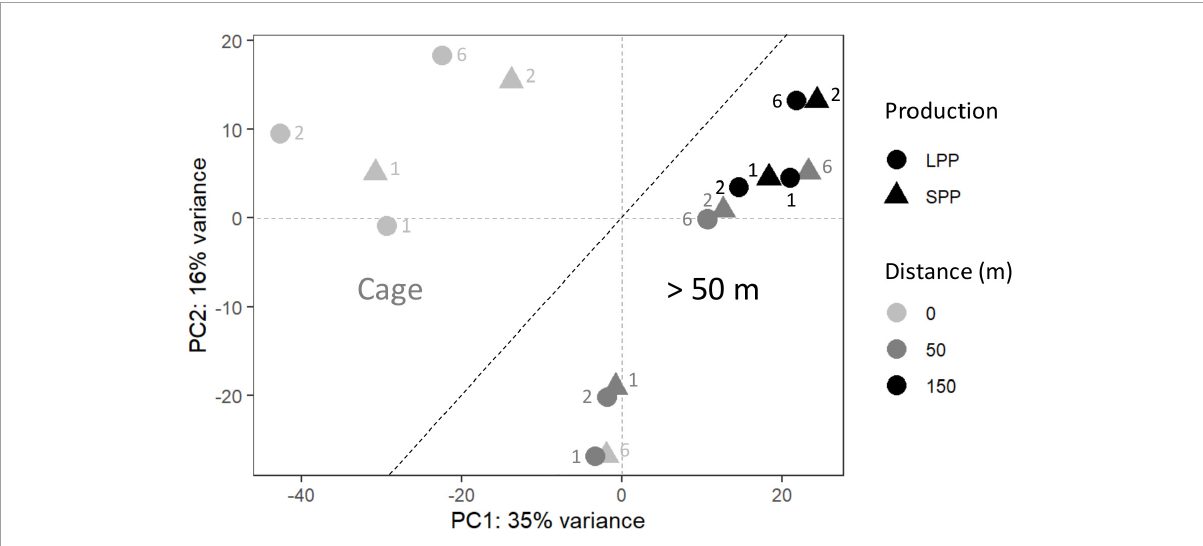
FIGURE2 Principal coordinate analysis (PCoA) of the microbial community from fish farm sediment (field samples). The compositional nature of the data was considered by applying a variance stabilizing transformation. Two groups were identified, one for microbial communities from sediment at the Cages (Left), and those found > 50 m away from cages (Right). SPP, short production period; LPP, long production period. Sediment layer depth intervals are indicated as follows: 1 = 0–0.5 cm, 2 = 0.5 − 1.0 cm, 6 = 3.0–5.0